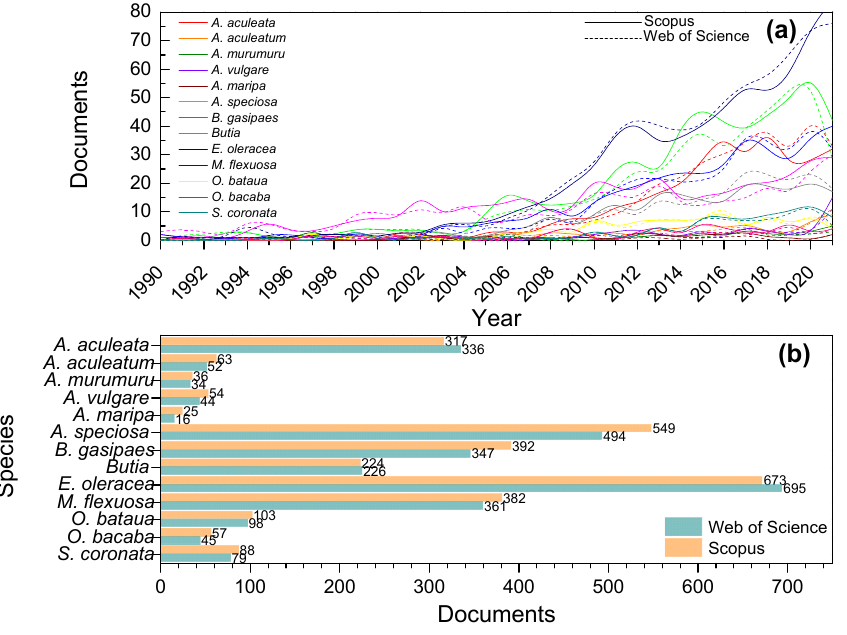
Figure 5. The evolution of studies related to 13 different Arecaceae palm trees on Scopus ® and Web of Science ( a ) and a comparison of total documents in each database between 1990 and 2021 ( b ). Adapted from Refs. [24,25]. Accessed on 2 June 2022.